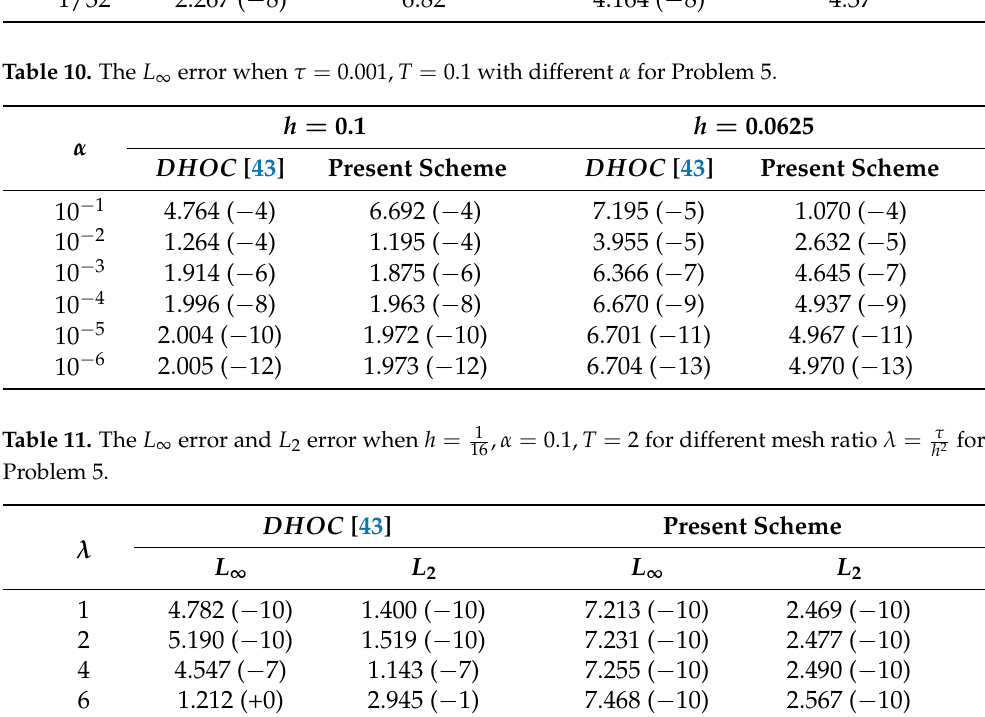
Table 10. The L ∞ error when τ = 0.001, T = 0.1 with different α for Problem 5.